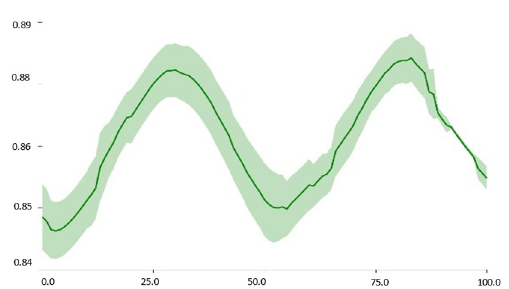
Figure 4. Center of mass variation of FF subjects alongside gait pattern.